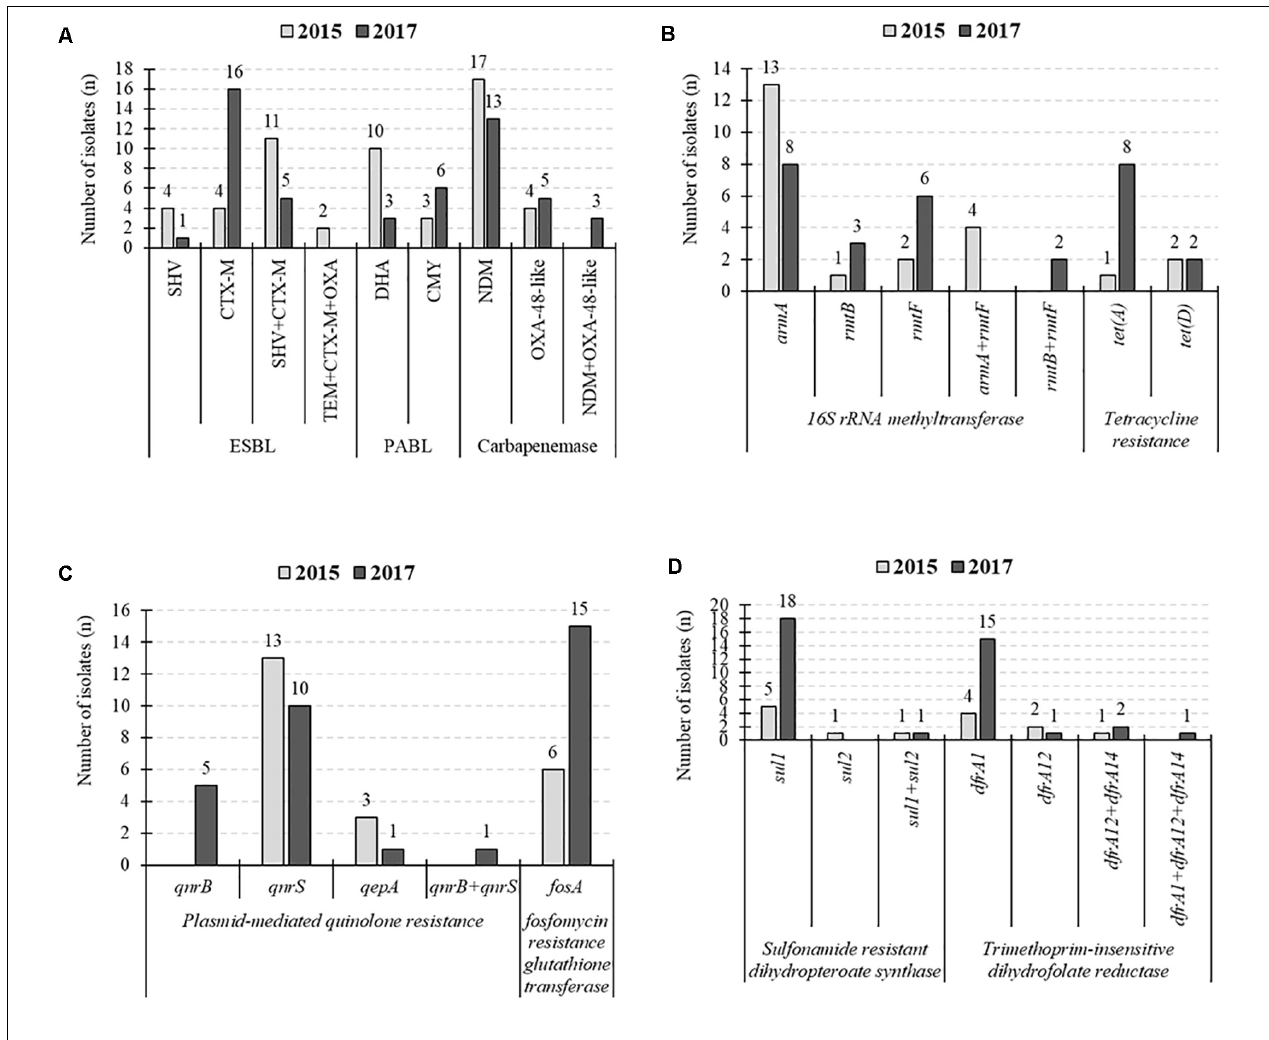
FIGURE 2 | Changes in the number of detected resistance genes. (A) Extended-spectrum β -lactamases (ESBLs)-, plasmid-mediated AmpC β -lactamase (PABLs)-, and carbapenemase-producing genes. (B) 16S rRNA methyltransferase- and tetracycline resistance protein-producing genes. (C) Plasmid-mediated quinolone resistance and fosfomycin resistance genes. (D) Sulfonamide resistance genes and dihydrofolate reductase encoding